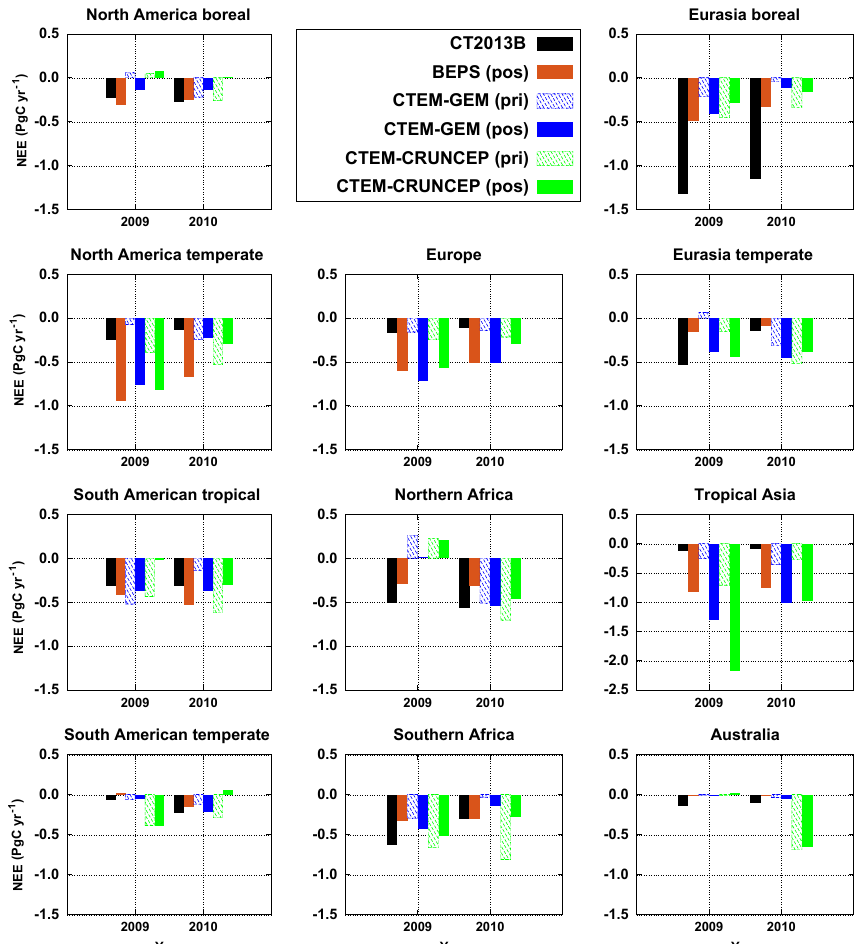
Figure 13. The annual total of the optimized NEE from GEOS-Chem using three different prior flux estimates of NEE from CTEM-GEM, CTEM-CRUNCEP, and BEPS (indicated as well) in comparison to the optimized NEE from CT2013B integrated over the 11 TransCom land regions. Table 6. The mean differences and RMSEs (in ppm) of the a posteriori CO 2 fields, based on CTEM-CRUNCEP, CTEM-GEM, and BEPS fluxes, with respect to aircraft data from the HIPPO-1, HIPPO-2, and HIPPO-3 campaigns. Mean (mod − obs) RMSE (mod − obs) Altitude Latitude CTEM-CRUNCEP CTEM-GEM